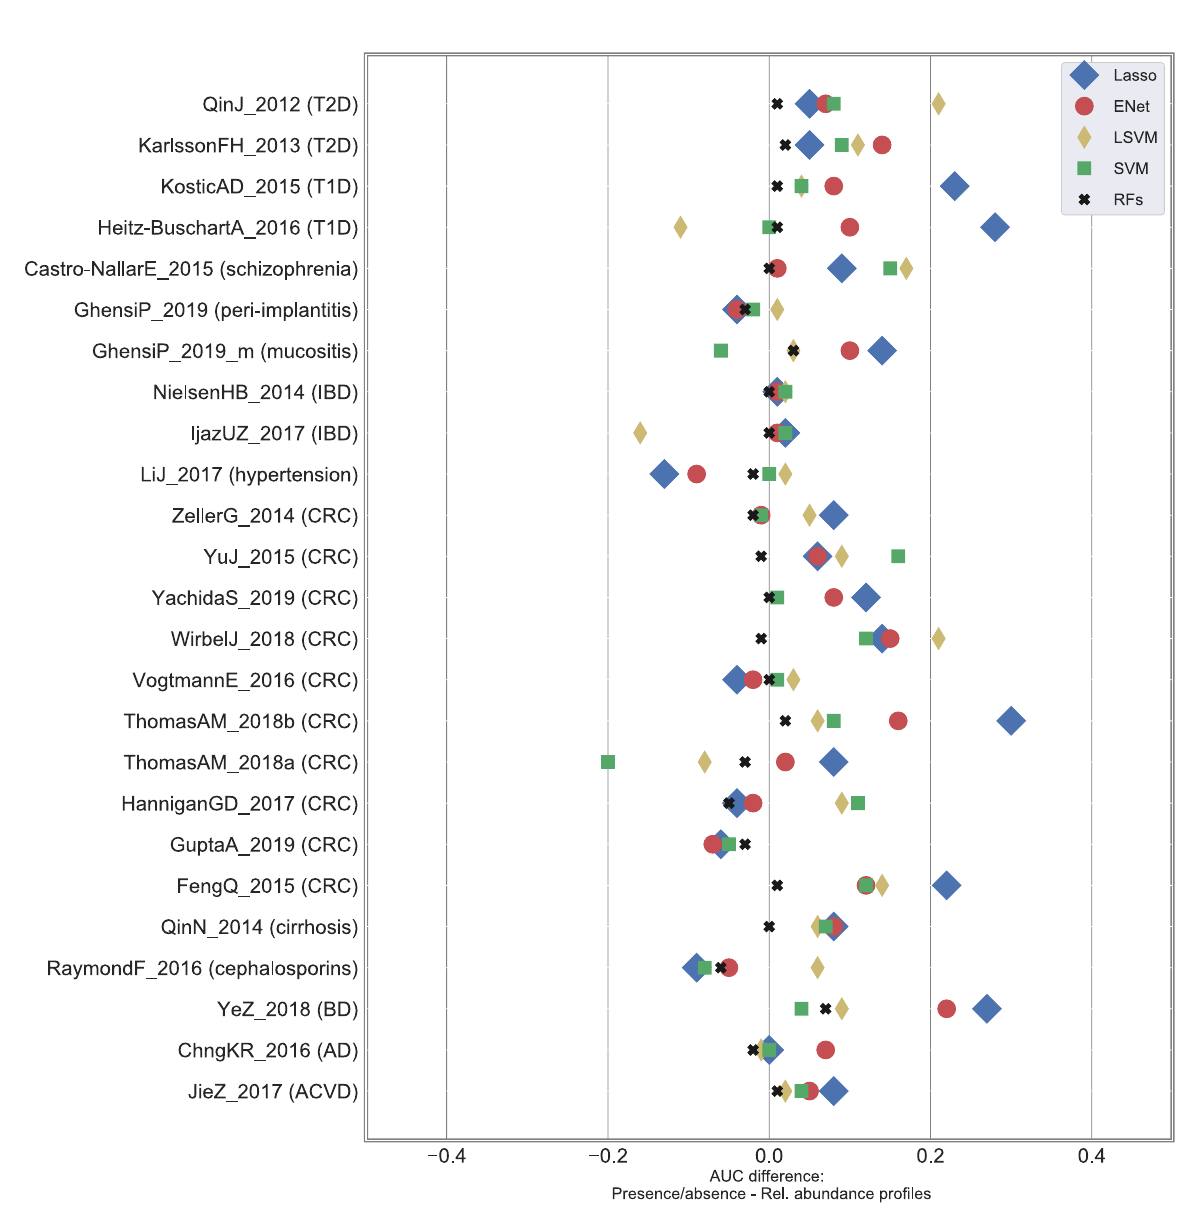
Fig 5. Findings in terms of stability of the classification accuracy are robust to the classifier choice. Differences in terms of AUC between presence/absence and relative abundance profiles for the 25 case-control shotgun datasets at varying classification algorithms. ENet: Elastic Net; LSVM: SVM with linear kernel; SVM: SVM with RBF kernel; RFs: Random